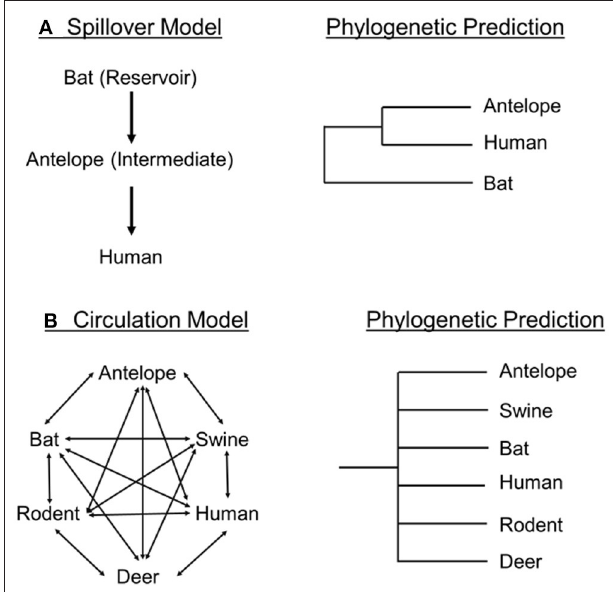
FIGURE 1 | Spillover Model (A) and Circulation model (B) as presented by Frutos et al. ( 19) and their phylogenetic predictions for viral transmission.